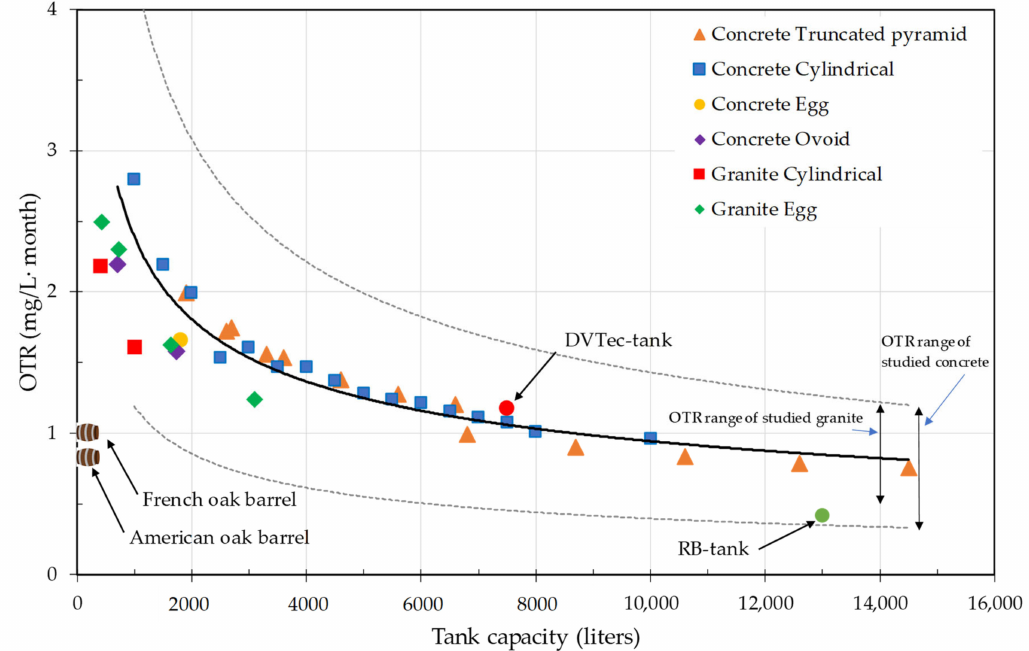
Figure 14. Variation of monthly average OTR (mg/L · month) in tartaric acid conditioned concrete tanks for the average measured OTR in liquid contact mode (equivalent to real working conditions), and for granite tanks based on dimensional specifications of commercial tanks and different shapes. The possible contribution of the different elements (valves, lids, etc.) of a tank to the OTR was not considered. Dotted lines refer to the mean ±